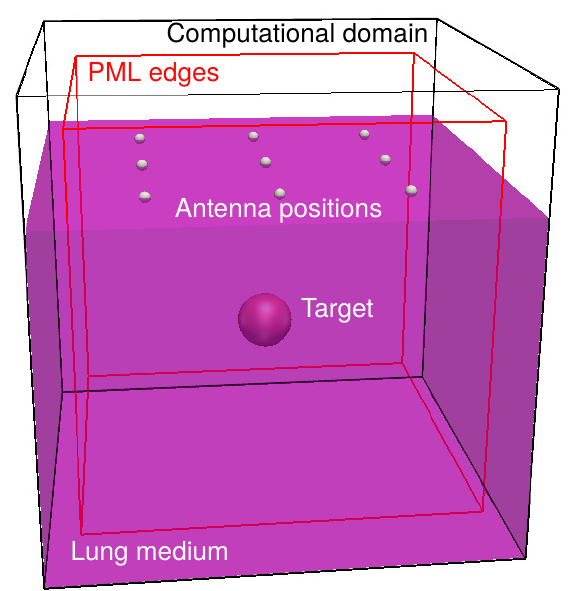
Figure 2. Schematic of the 3D computational domain. The violet parallelogram represents the lung medium. Inside the lung medium, the target is present (red sphere). On top of the lung medium a 3 × 3 antenna distribution is shown. A simulation was performed at each of these positions. The edge of the Perfectly Matched Layers (PMLs) are shown in